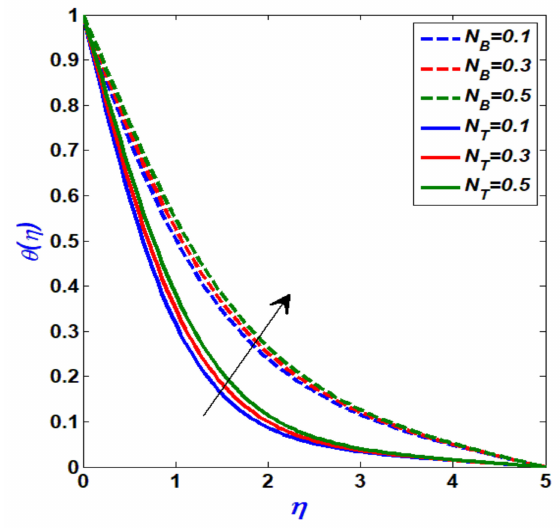
Figure 6. Temperature profile with variation in, N B and N T .